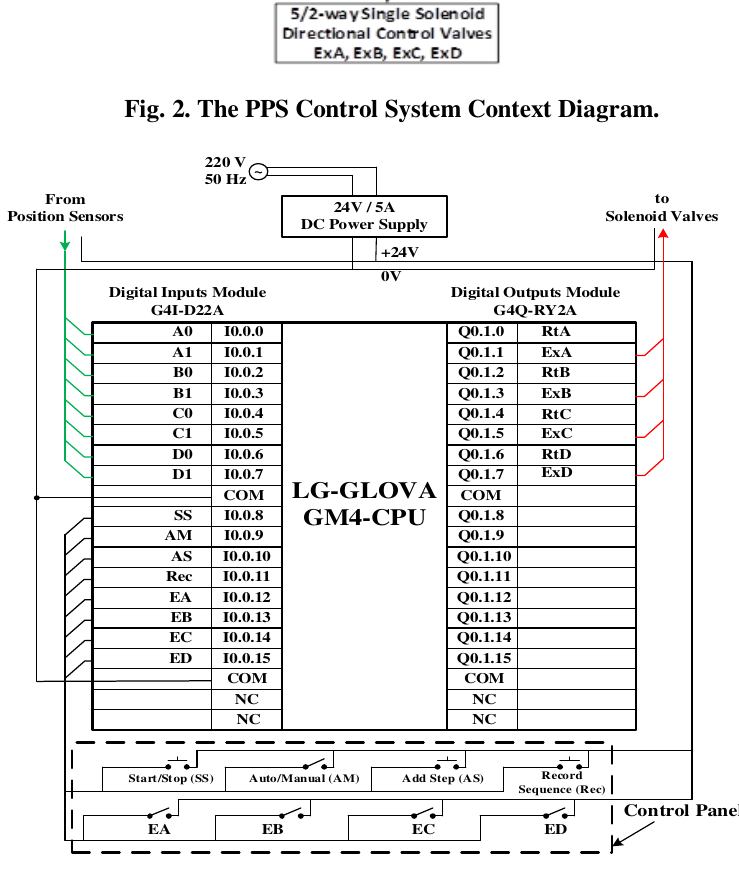
Fig. 3. The PLC and Control Panel